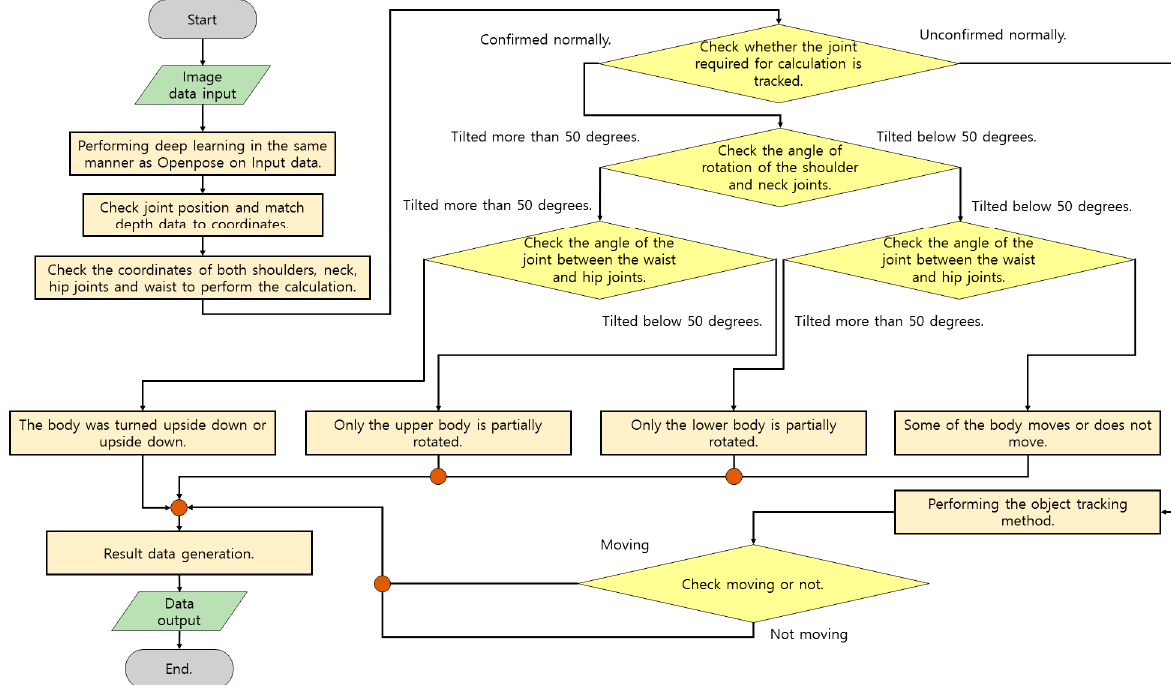
Figure 5. Flow chart of the system to prevent bedsores.